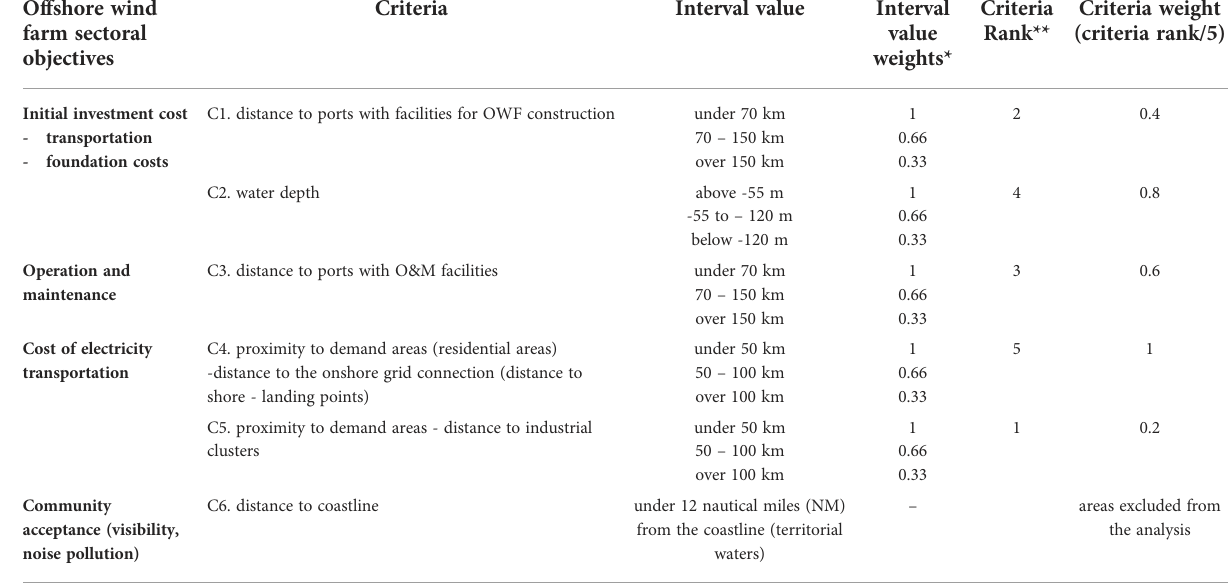
TABLE 1 Explicit OWF site allocation criteria, for the calculation of valuable OWF